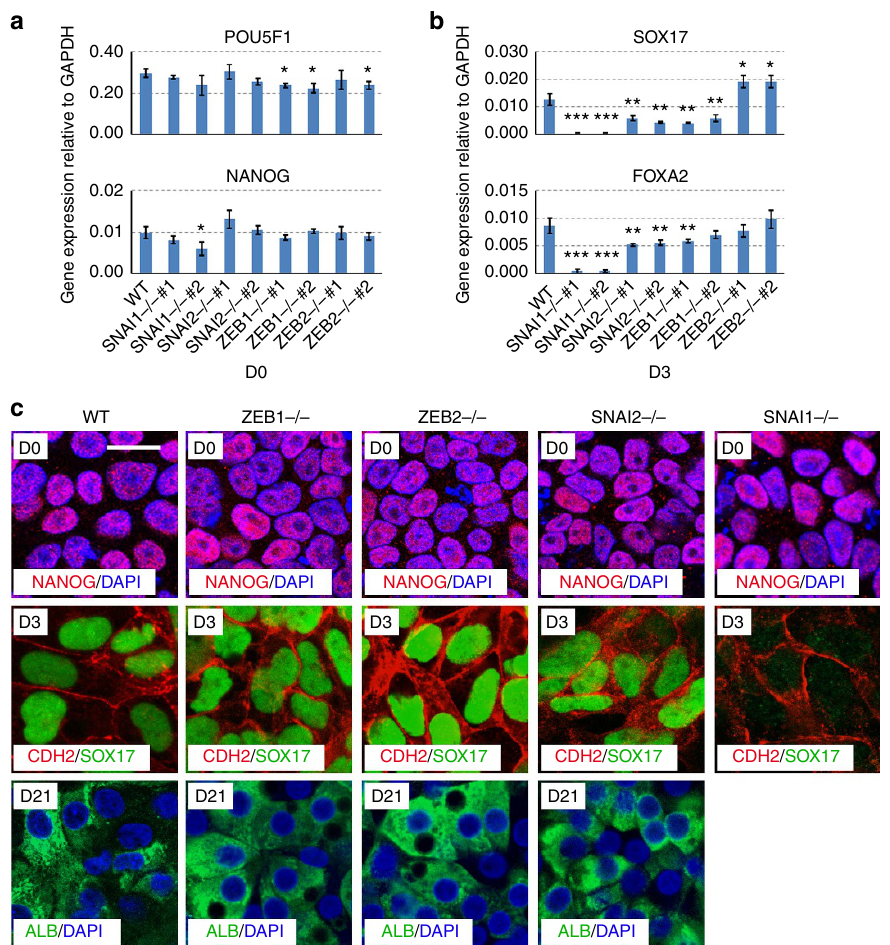
Figure 5 | Analysis of the role of EMT-related transcriptional factors in hepatic differentiation of hESCs. ( a ) qRT-PCR analysis of the expression of pluripotency genes in wild-type (WT) and SNAI1/2 and ZEB1/2 knockout cell lines. Significance between WTand mutants were determined using Student’s unpaired t -test (* P o 0.05). ( b ) qRT-PCR analysis of the expression of DE markers in WT and mutant hESC lines. Data represent mean ± s.d. from three biological repeats in a , b . Significance between WT and mutants were determined using Student’s unpaired t -test (* P o 0.05; ** P o 0.01; *** P o 0.001). ( c ) Immunofluorescence staining analyses for the hepatic differentiation of hESC lines. Scale bar, 20 m